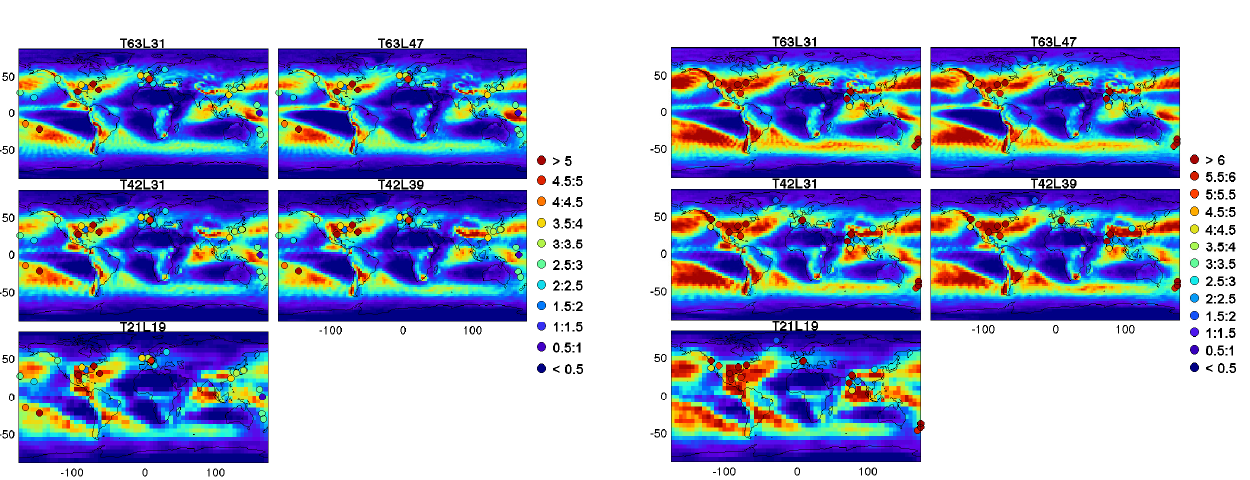
Fig. 4. 1998–2002 mean deposition flux of 7 Be atoms (100 m − 2 s − 1 ) with different model resolutions. The dots show the location and observed deposition flux of the measurement stations (refer- ences given in the text).